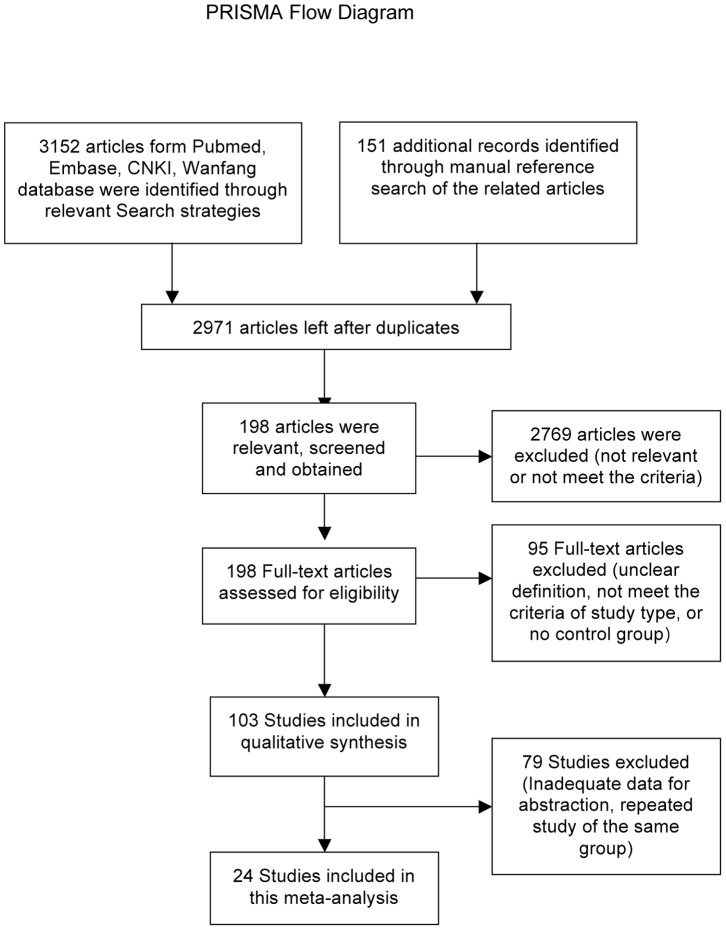
PRISMA Flow Diagram.